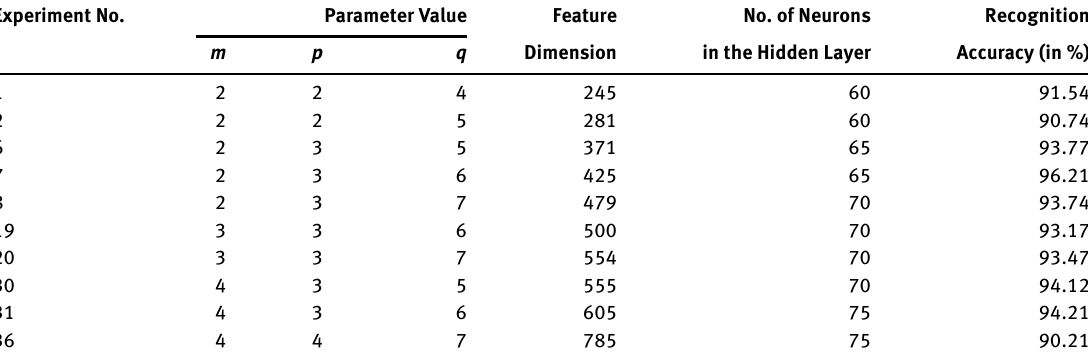
Table 3: Top 10 Recognition Results with Different Sets of Parameter Values Applied in a Five-Fold Cross-validation Mechanism. Experiment No.